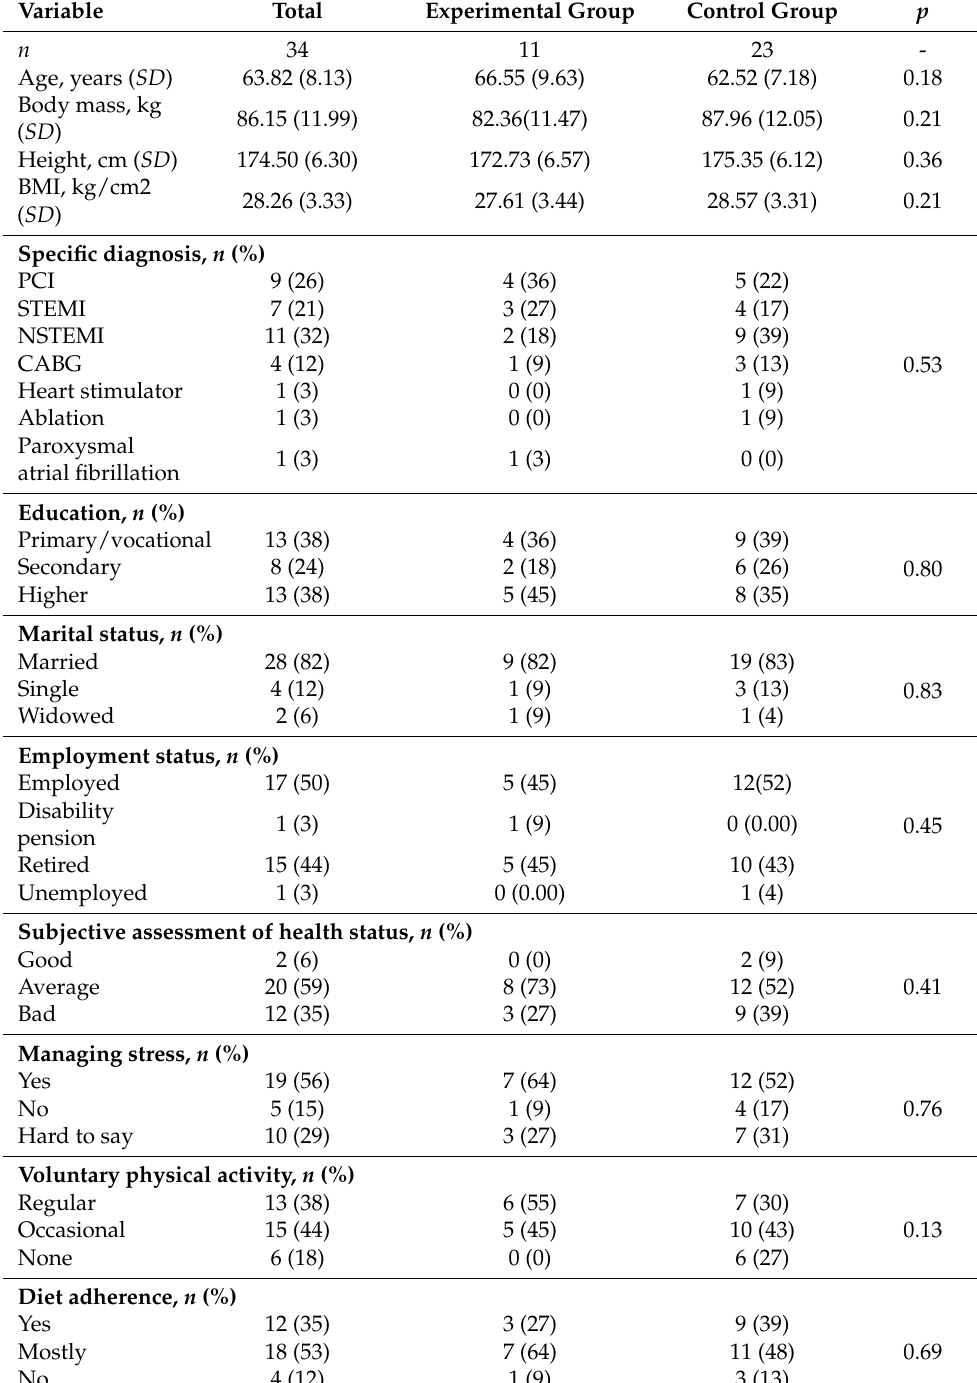
Table 1. Participants baseline